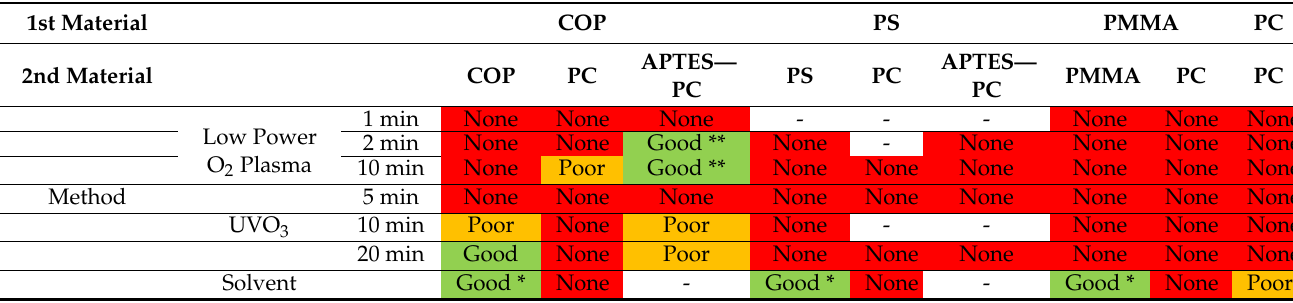
Figure A3. Schematic of cell-seeding areas in OoC device. ( A ) Top view of a µBBB device with an augmented image of the grid indicating an example of a top channel (vertical), bottom channel (horizontal), and a cross-section (indicated with a square in the centre). ( B ) Schematic of the transversal structure of each cross-section in the device. Pericytes are seeded in the top channel in contact with the polycarbonate membrane. Endothelial cells are seeded in the top channel, both in contact with the membrane and in contact with the bottom of the device. Each channel is supplied with its own cell-specific culture medium. The positions analysed for imaging purposes are indicated as bottom-position and membrane-position. Table A1. Direct polymer bonding results. (*) low optical quality; (**) Good results only on one side of the membrane, unable to obtain a proper polymer-PC membrane-polymer sandwich; (-) not tested. 1st Material COP PS PMMA PC APTES— APTES— 2nd Material COP PC PS PC PC PC